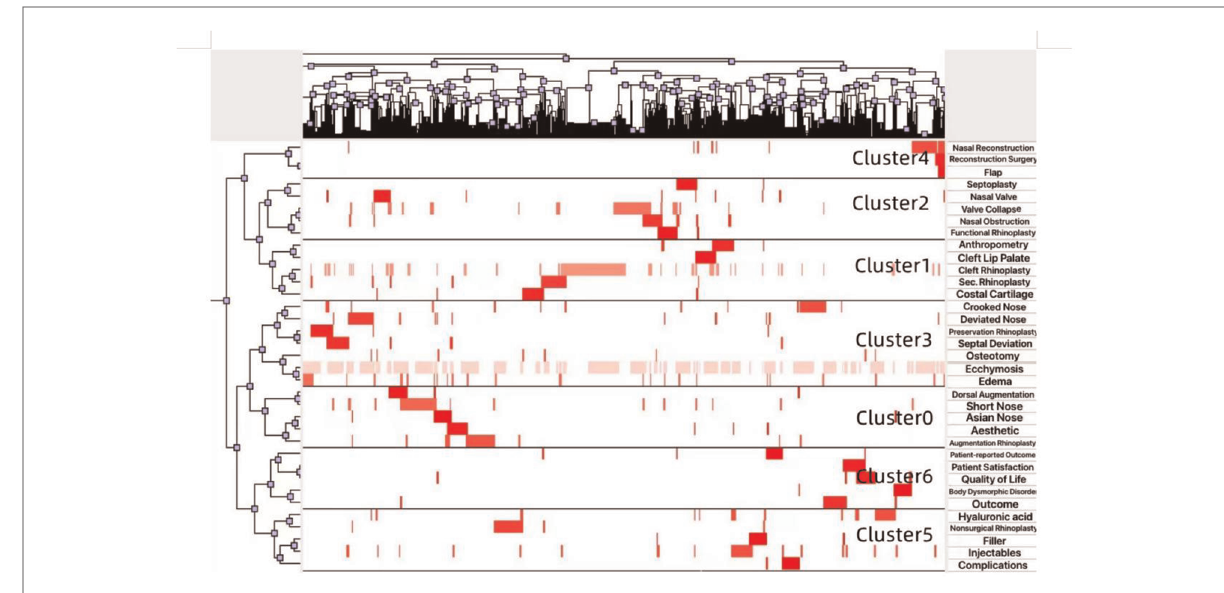
FIGURE 11 Matrix visualization conducted by gCLUTO (version1.0, University of